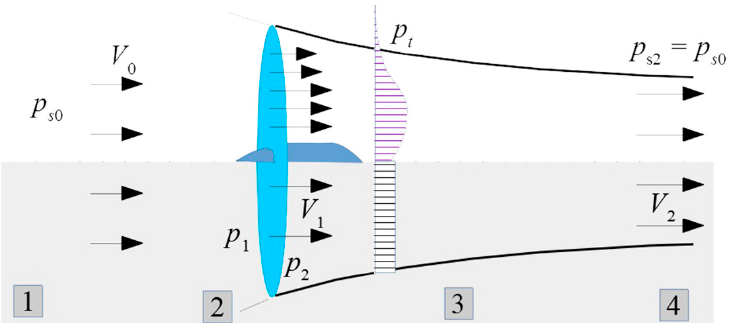
Figure 2. Propeller airstream: shadowed as stated by simplified actuator disk theory (1—uniform stream of incoming air or steady air, 2—unsteady area of air sucked by propeller, 3—unsteady area of air after propeller, 4—steady stream after propeller [17].